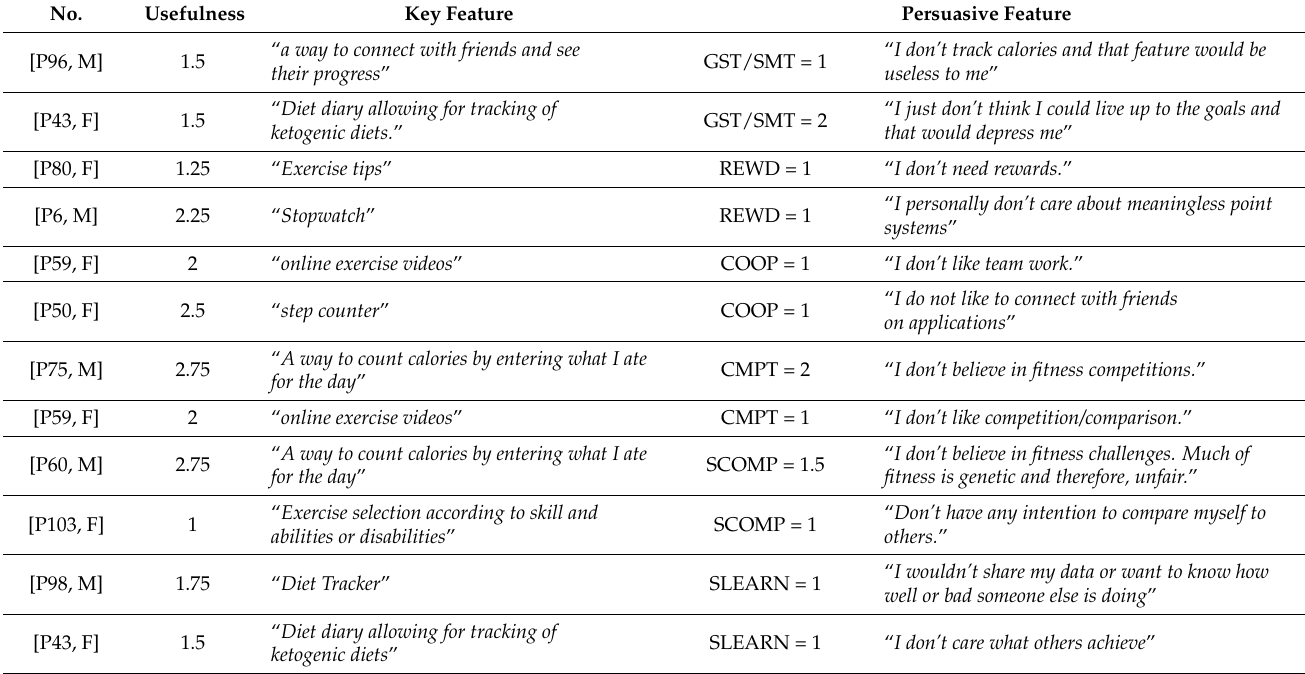
Table 9. Sample comments on the relationship between perceived usefulness and non-receptiveness to persuasive fea- tures. GST/SMT = Goal-Setting/Self-Monitoring, REWD = Rewards, COOP = Cooperation, CMPT = Competition, SCOMP = Social Comparison, SLEARN = Social